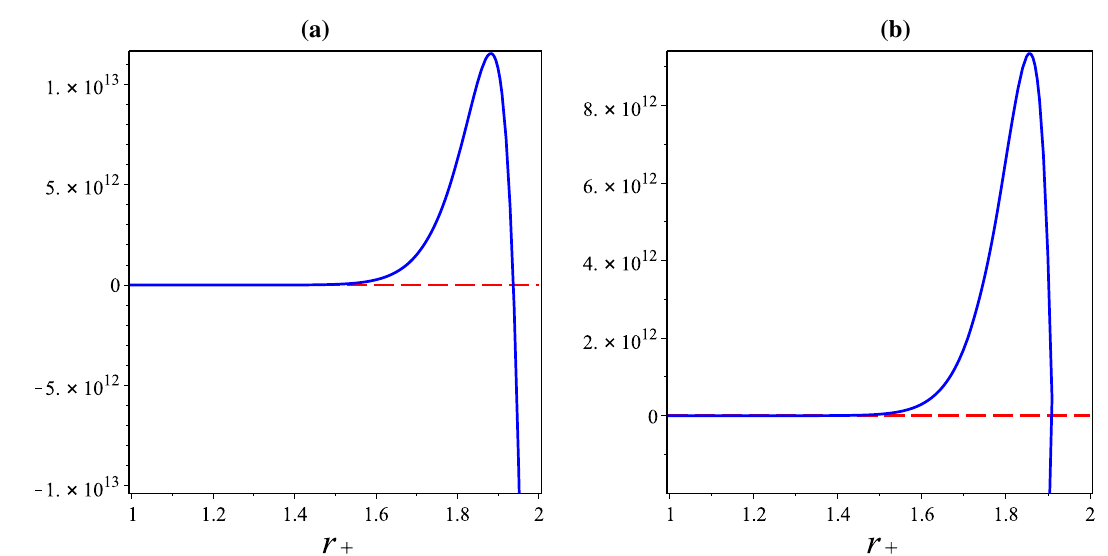
, while solid blue lines dV